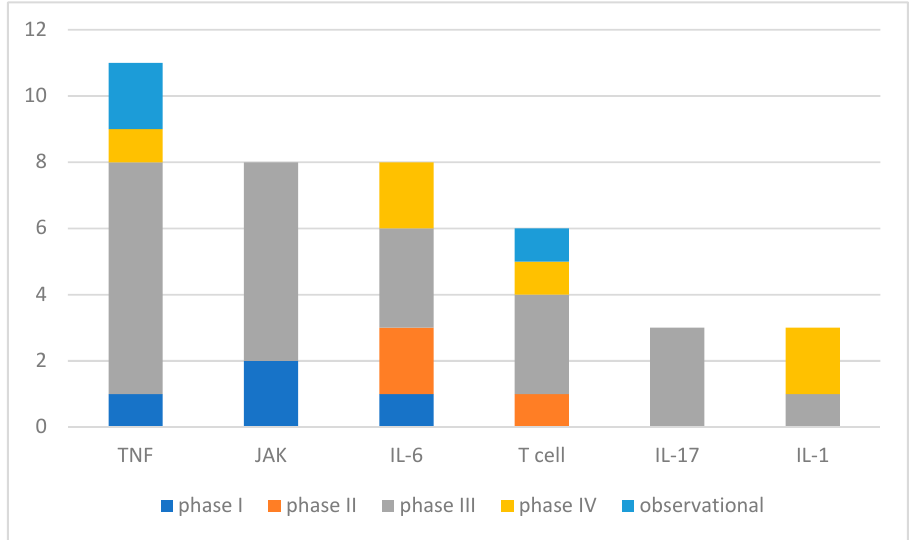
Figure 3. Number of studies concerning bDMARDs and tsDMARDs sorted for biological targets (interventional and observational studies, partly multiple agents involved per study). IL—interleukine, JAK—janus kinase, TNF—tumor necrosis factor.